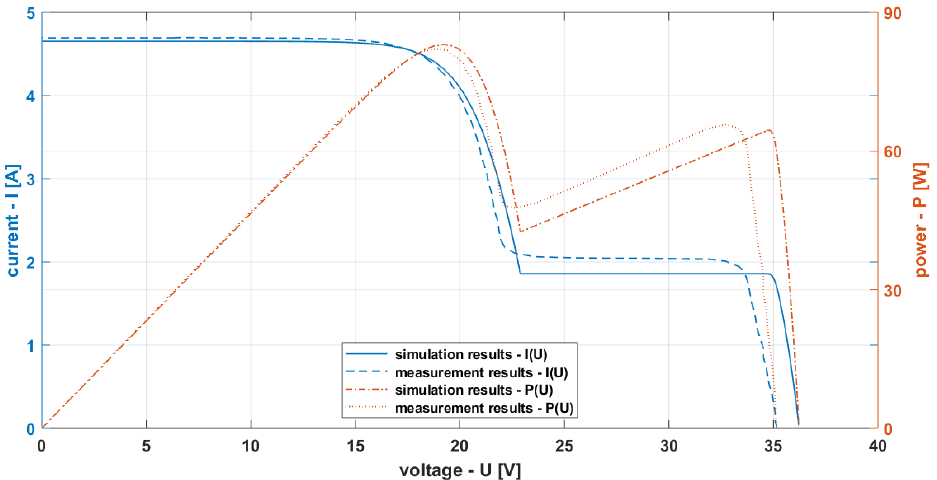
Figure 6. I–V characteristics of PV module STP255-20/Wd made with partial shading. For detailed comparison of measurement and simulation results, see Table 2. Marking of measurement point P1 (two PV cells were shaded; the exact measurement time was 10:24 a.m..